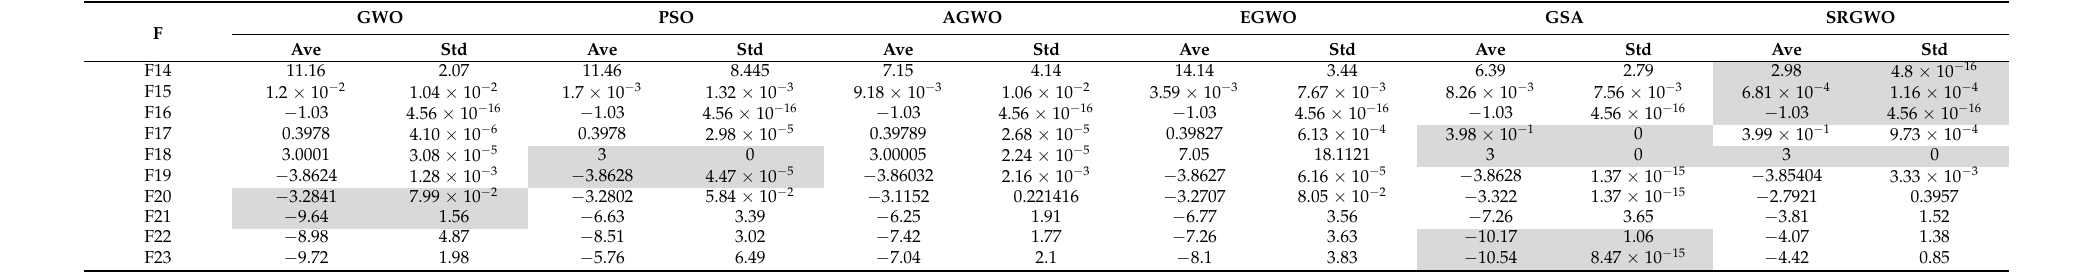
Table 3. Simulation results of fixed-dimension multi-modal